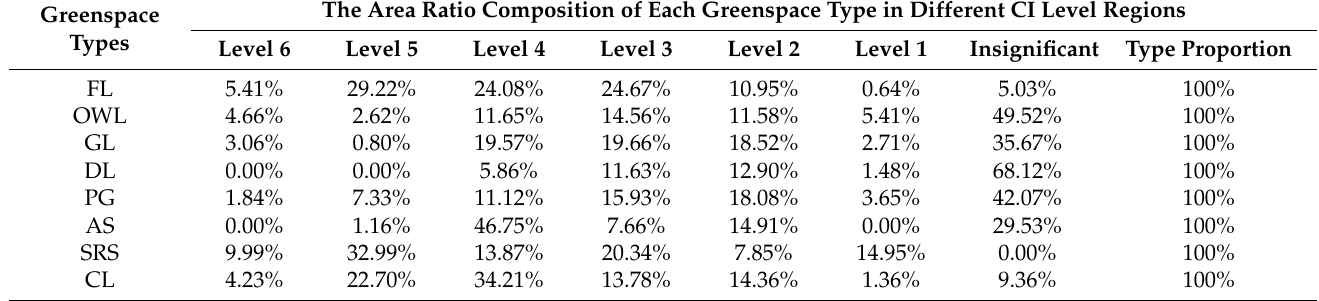
Table 4. The composition of each riverfront greenspace type in CI regions with different levels.